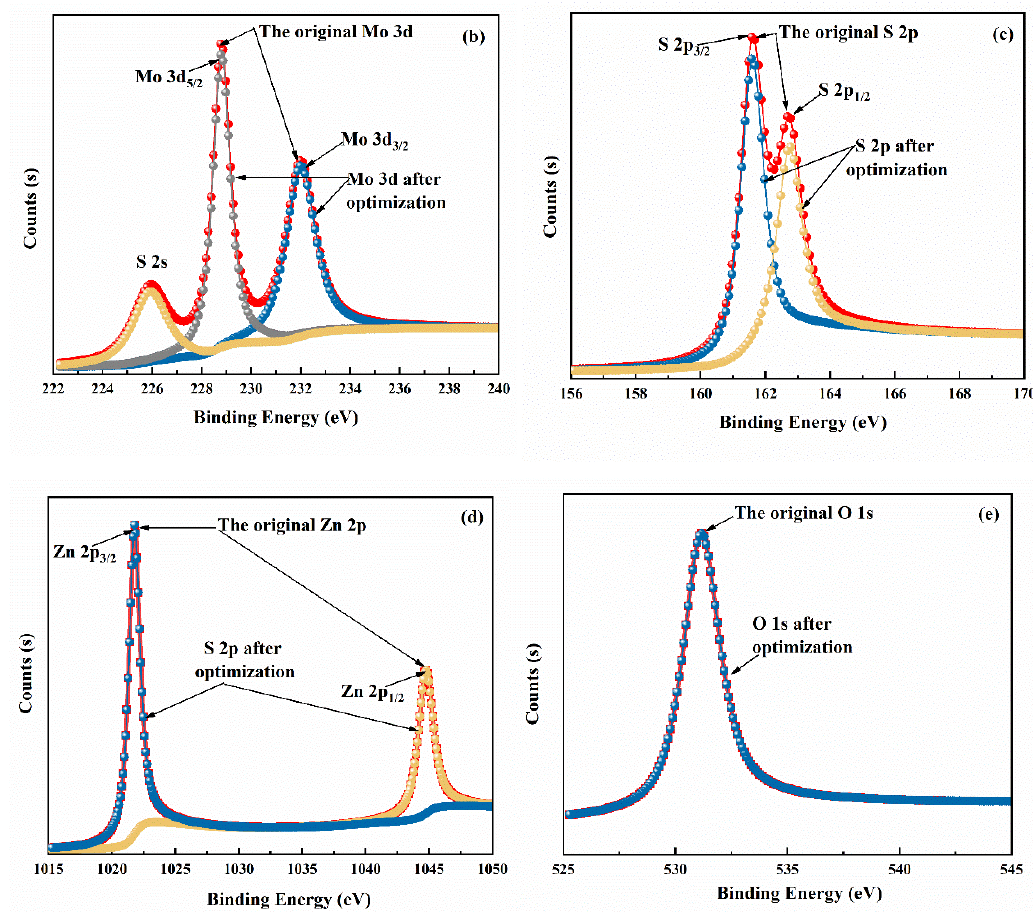
Figure 7. X-ray photoelectron spectroscopy (XPS) data graph in ZnO-MoS 2 nanocomposite in S3: ( a ) all elements spectrum; ( b ) Mo 3d spectrum; ( c ) S 2p spectrum; ( d ) Zn 2p spectrum; ( e ) O 1s spectrum.